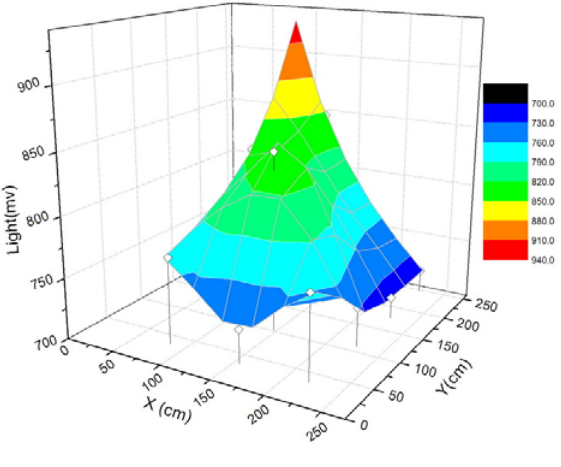
Figure 19. Light gradient measured by the deployed mobile sensor